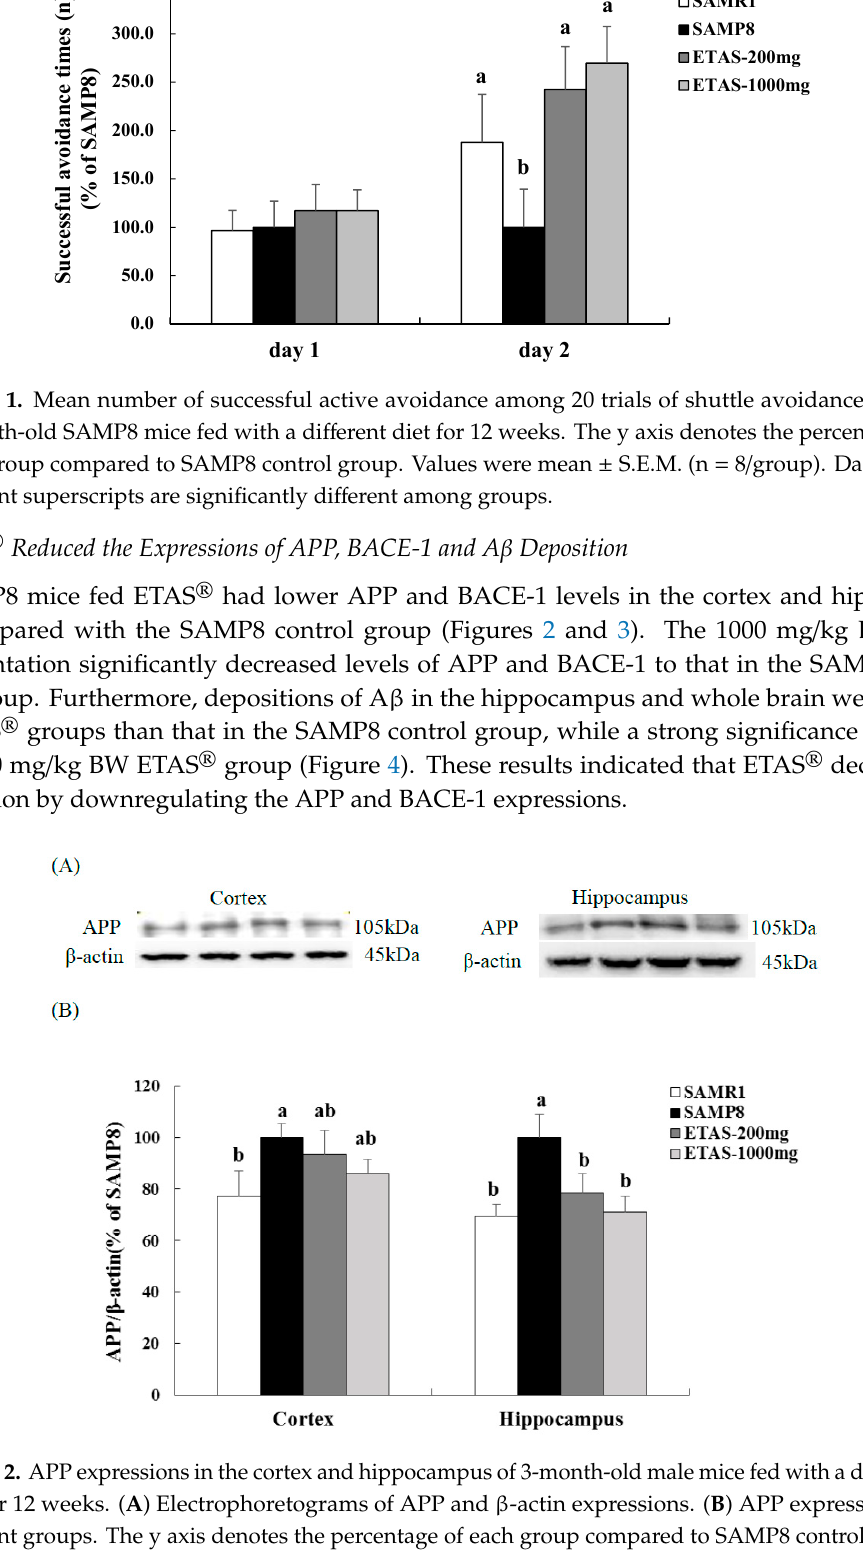
Figure 2. APP expressions in the cortex and hippocampus of 3-month-old male mice fed with a different diet for 12 weeks. ( A ) Electrophoretograms of APP and β -actin expressions. ( B ) APP expressions of different groups. The y axis denotes the percentage of each group compared to SAMP8 control group. Values were mean ± S.E.M. (n = 8/group). Data with different superscripts are significantly different among groups.